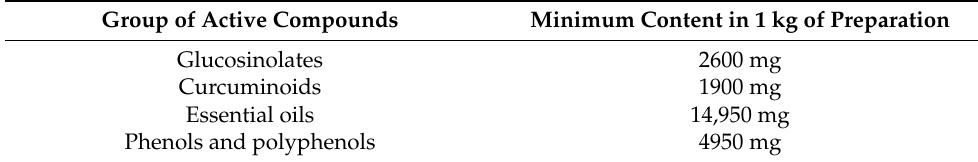
Table 3. Content of the main groups of active substances in the